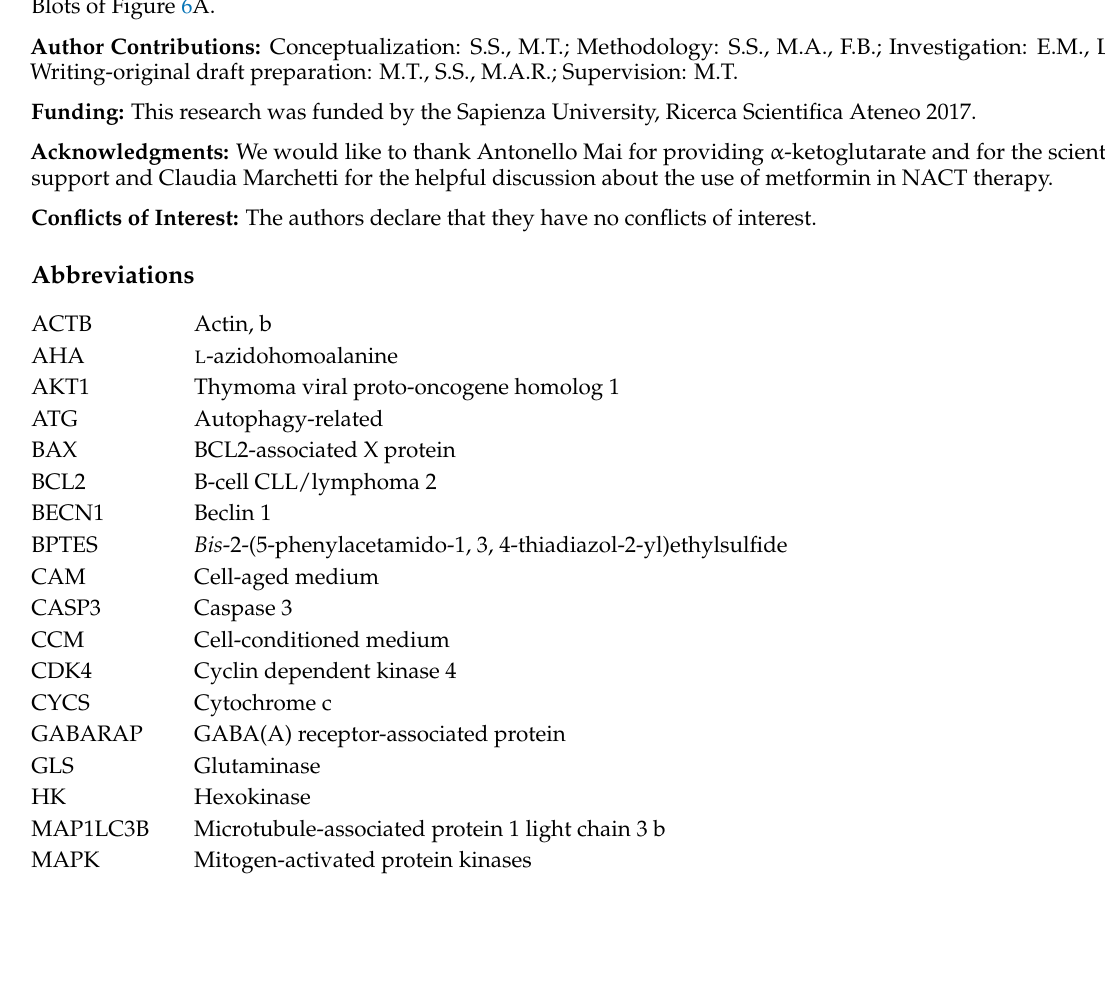
Figure S1. Densitometric analysis of Western Blots of Figure 2C. Figure S2. Densitometric analysis of Western Blots of Figure 4A. Figure S3. Densitometric analysis of Western Blots of Figure 4B–D. Figure S4. Inhibition of GLS reduces autophagy. Figure S5. Metformin inhibits autophagy in MCF7 cells. Figure S6. Autophagy inhibition by metformin is MTOR -independent. Figure S7. Densitometric analysis of Western Blots of Figure 5D. Figure S8. Metformin inhibits autophagy in galactose supplemented medium. Figure S9. Densitometric analysis of Western Blots of Figure